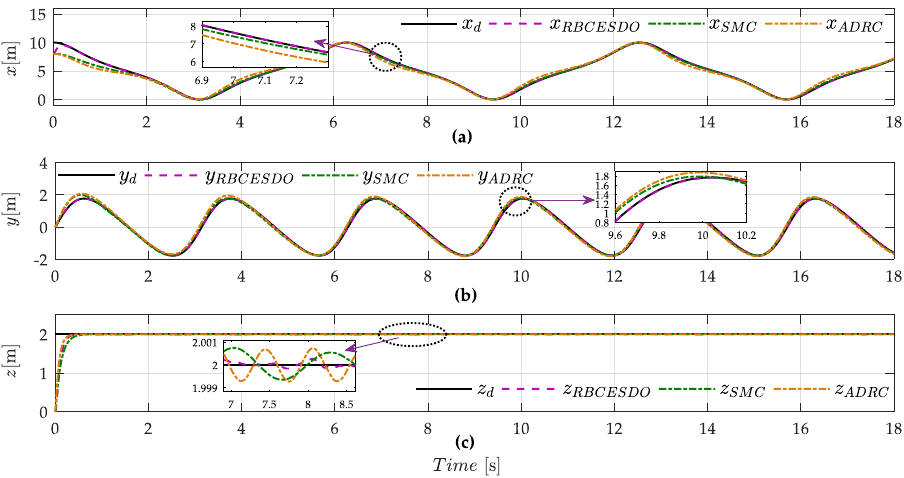
Figure 6. Comparison of position performance between the proposed RBCESDO, SMC, and ADRC: horizontal position x ( a ), y ( b ), and vertical position z ( c ).